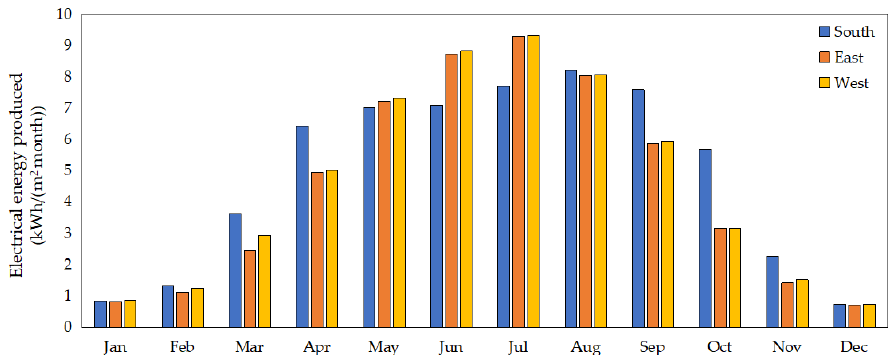
Figure 12. Monthly electrical energy produced by SPBs per unit of vertical surface.